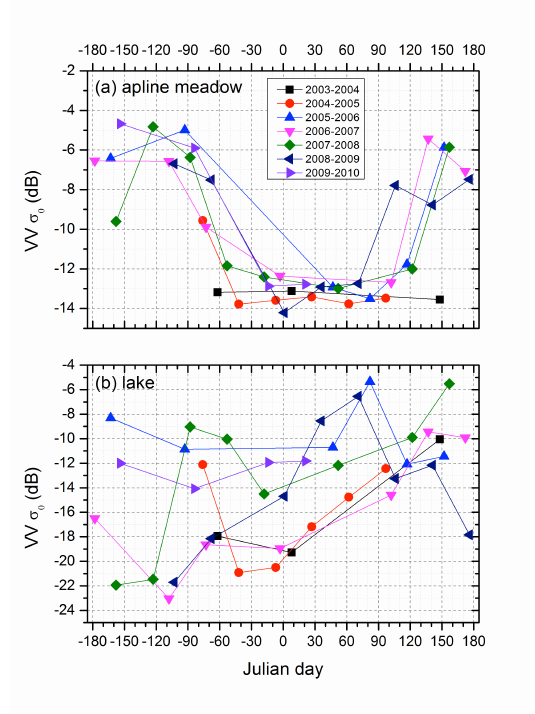
Figure 6. Time series σ 0 observed by SAR over (a) alpine meadow and (b) thermokarst lake (The negative number of Julian day denotes as the last year